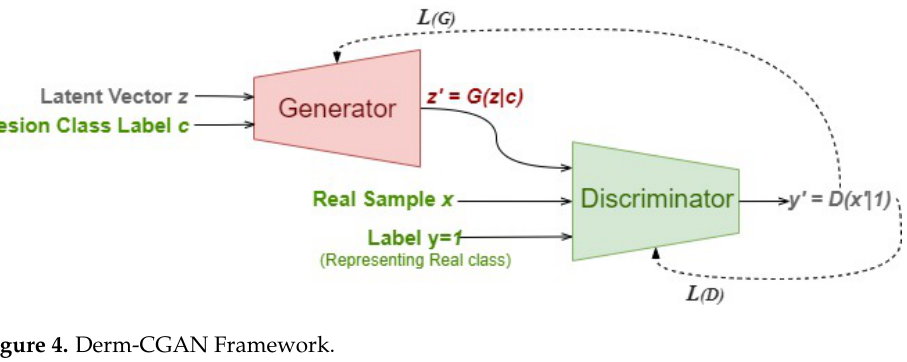
Figure 4. Derm-CGAN